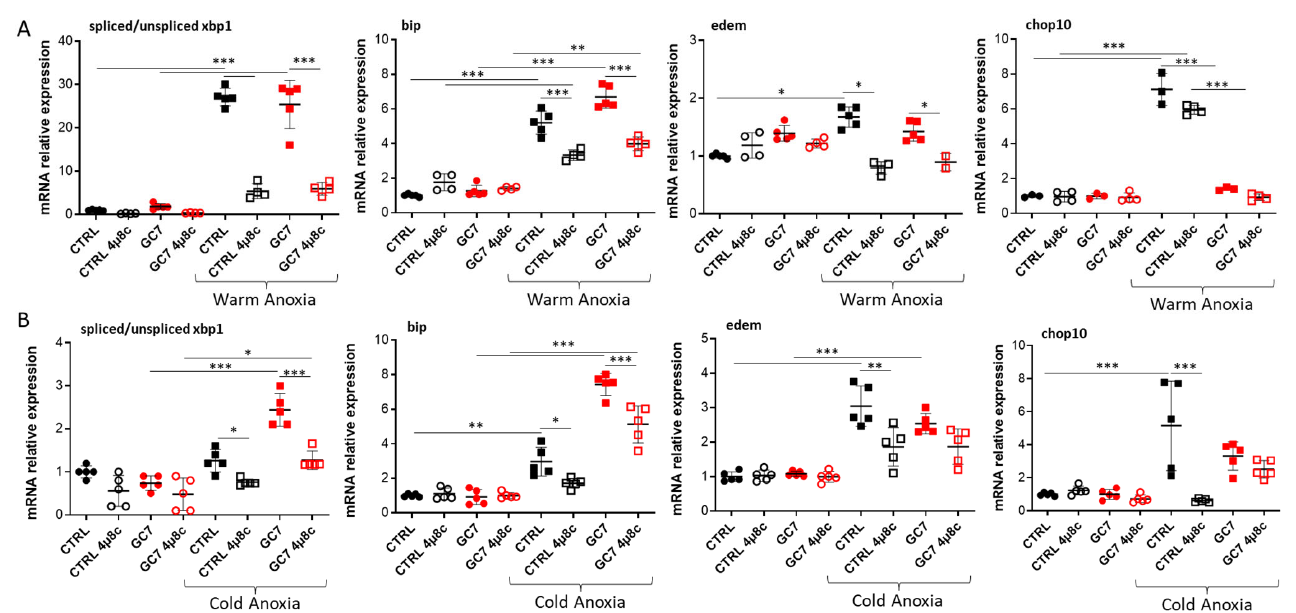
Figure 6. 4 µ 8c effect on the expression of IRE-1 α pathway members modulated by GC7. PCT cells pre-treated for 8 h either with a vehicle or with 30 µ M GC7 and 24 h later submitted to either ( A ) warm (37 ◦ C, 24 h) or ( B ) cold (4 ◦ C, 16 h) anoxia ( ≤ 0.1% O 2 ), in presence or not of 1 µ M of the IRE-1 α inhibitor 4 µ 8c. At the end of the experiments, cells were either lysed for mRNA expression. Scatter plot representation of individual values along with mean ± SD for the ratio of spliced/unspliced xbp1 mRNA and the relative expressions of edem and bip . n = 5, * = p ≤ 0.01; ** = p ≤ 0.001; *** = p ≤ 0.0001.